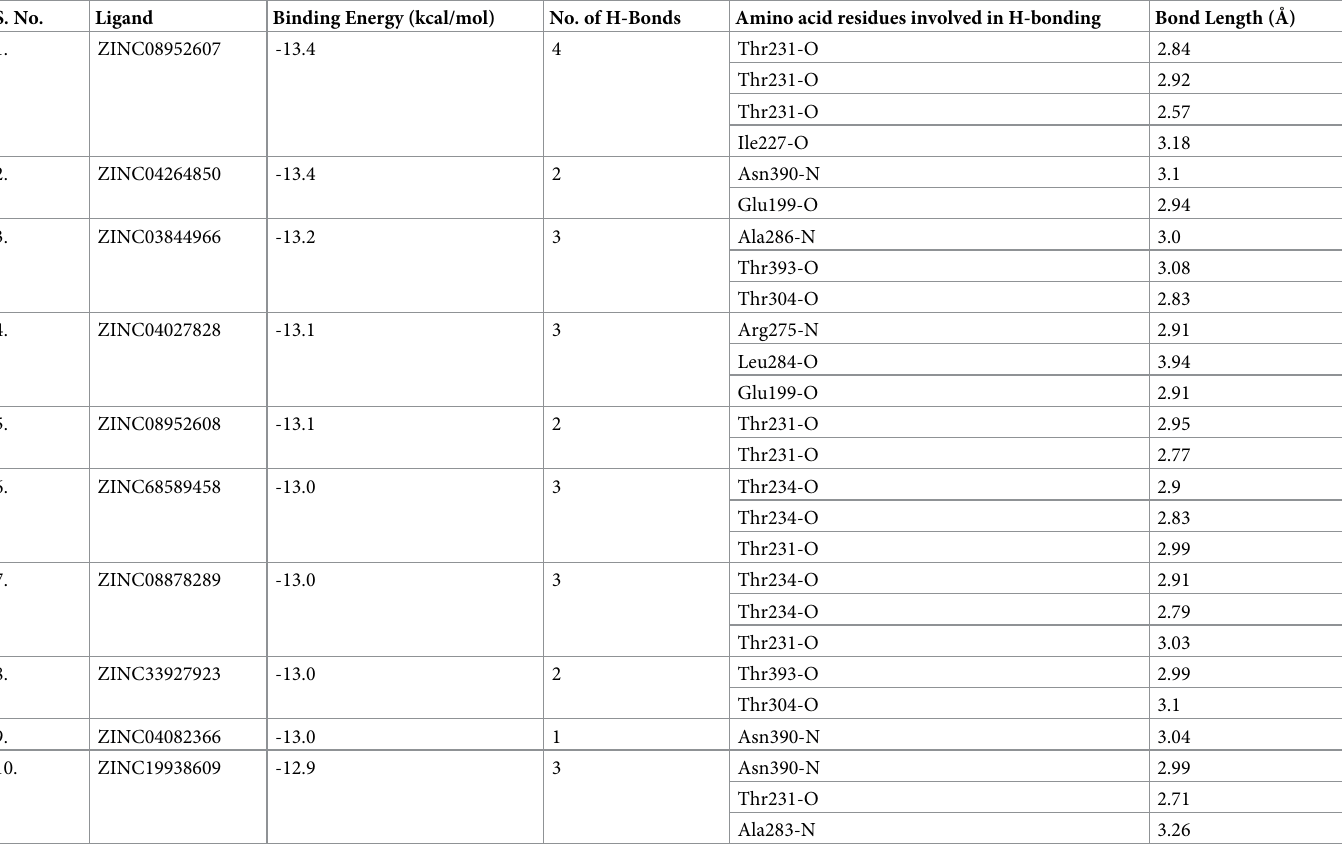
Table 1. Binding free energy, number of H-bonds formed, amino acid residues involved in H-bonding, and bond lengths for the top 10 docked complexes. S.